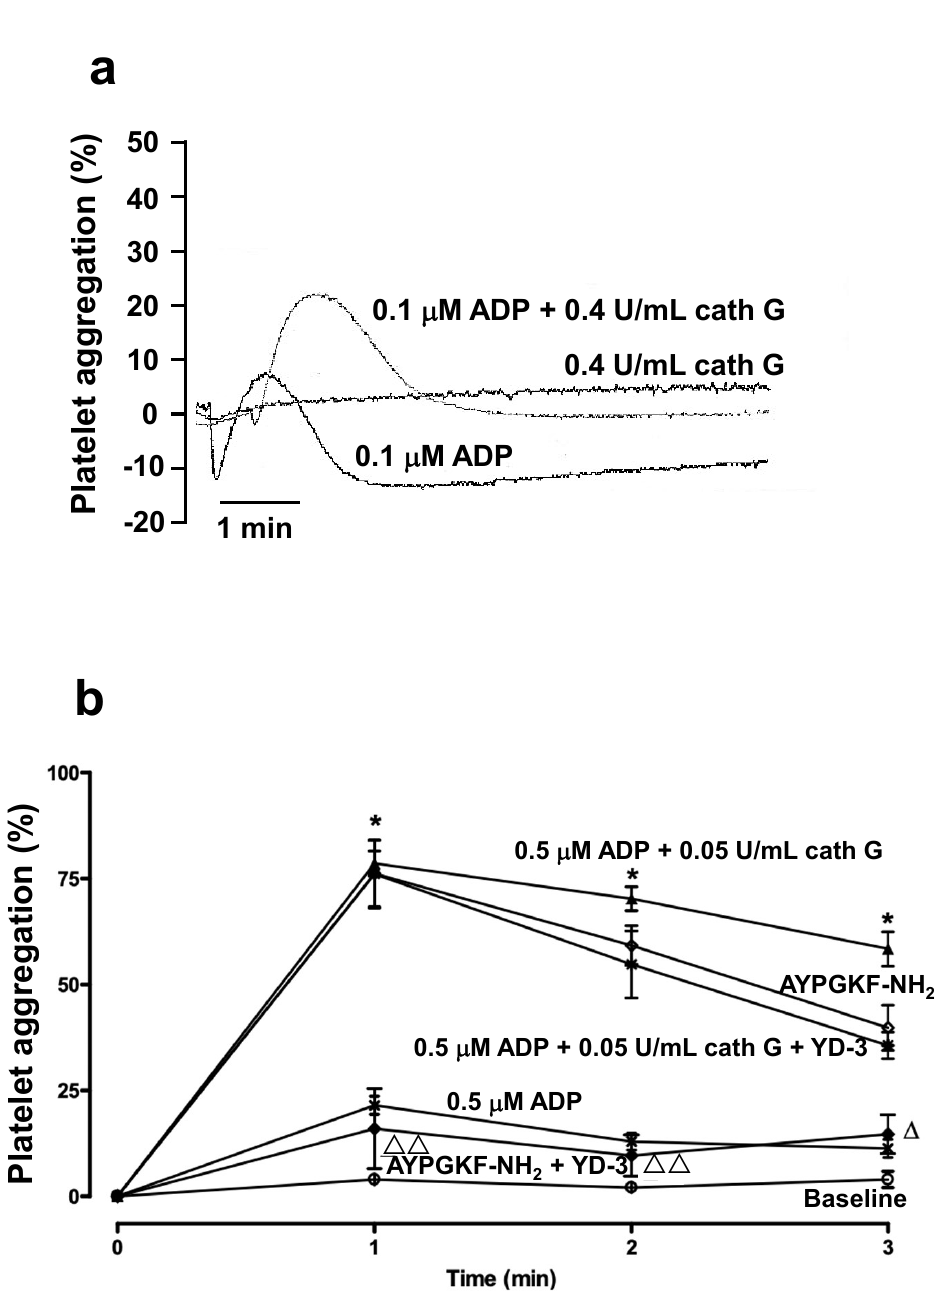
Figure 4. Murine platelet aggregation by cathepsin G: Need for blood cells beyond platelets. ( a ) Platelet aggregation tracings in platelet-rich plasma of Swiss WT mice, by 0.1 µ M ADP, with or without cathepsin G (0.4 U/mL) pretreatment for 6 min at 37 ◦ C, and by cathepsin G alone, as indicated. Continuous tracings recorded on a Chrono-log aggregometer are representative of 3 independent experiments. ( b ) Platelet aggregation curves for Swiss WT mouse blood, in the absence of added agonist (Baseline, open circles), or induced by 0.5 µ M ADP without or with cathepsin G (0.05 U/mL) pretreatment for 6 min at 37 ◦ C, in the absence or presence of 100 µ M PAR4 antagonist YD-3; tracings (without ADP) induced by 30 µ M PAR4 agonist AYPGKF-NH 2 in the absence or presence of 100 µ M PAR4 antagonist YD-3, as indicated. Data in b represent mean ± SEM ( n = 3–13 in each group). Statistical analysis was by one-way ANOVA, followed by Newman–Keuls multiple-comparison test (* p < 0.0001 vs. tracing for 0.5 µ M ADP; ∆ p < 0.01, ∆∆ p < 0.0001 vs. tracing for AYPGKF-NH 2 ). Platelet aggregation is calculated from residual platelet numbers at the indicated time